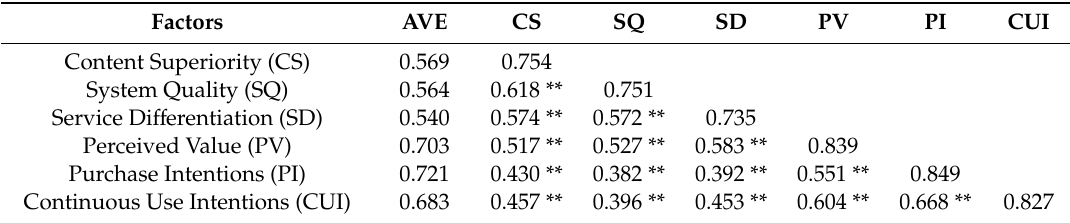
Table 4. Correlation matrix and Average Variance